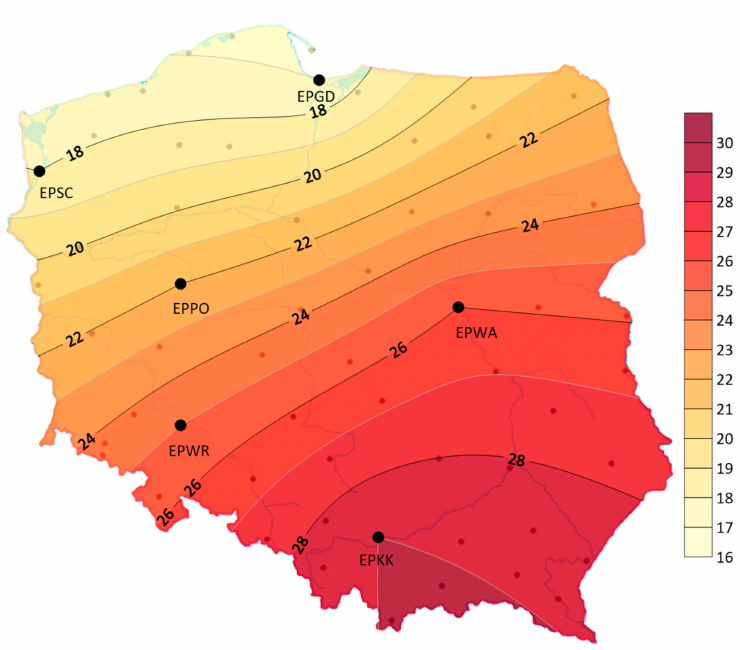
Figure 4. Average annual number of days with a storm in Poland (1970–2018). A data analysis shows that storms most often occurred in the warm months of the year. They appeared very rarely in the winter months. However, most often storms occurred in the summer months, with a maximum in July. In July, the frequency of storms ranged from about 4 storms in EPGD to 7 storms in EPKK. In the years 1970–2018, the most storms—15 (in 2012)—were recorded in EPPO (see Table 1). A frequent occurrence of storms in the summer months is caused by high air temperatures, intense evaporation, which promote the development of intensive convection and the formation of cumulonimbus clouds. In addition, in the warm season of the year, the influx of cool air masses from higher latitudes or from above water bodies over a warm land area also promotes the development of convection and the formation of storm